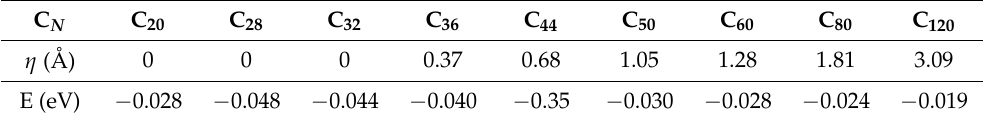
Table 2. Main results of the equilibrium position η and interaction energies E .